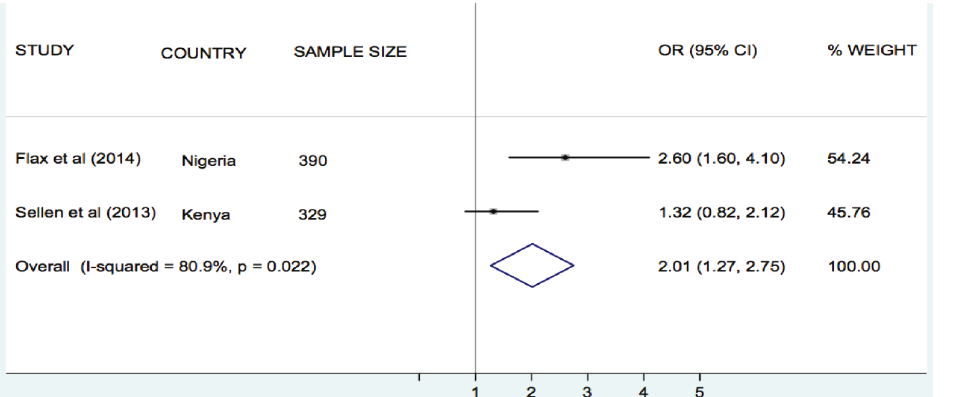
Figure 3. Meta–analysis of the effect of SMS/cell phone intervention vs routine prenatal care on initiation of breastfeeding within one hour after birth based on two RCT undertaken in Nigeria and Kenya: OR represents the odds ratio of